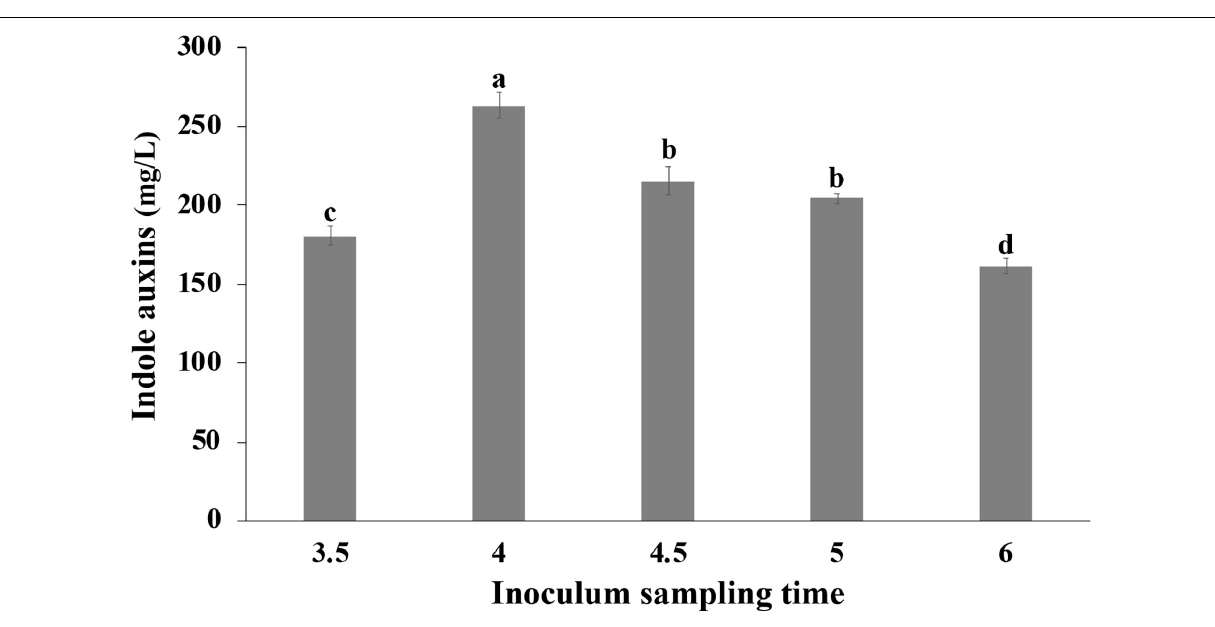
FIGURE 9 | Effect of the physiological state of the cells used for inoculation on IAA production. Pantoea agglomerans strain C1 was cultivated on YES-tryptophan medium for 18 h, and cells used for the inoculum (OD = 0.5) were collected by the fermenter at the time points indicated on the x -axis. Differences in letters indicate that the values are significantly different ( P >